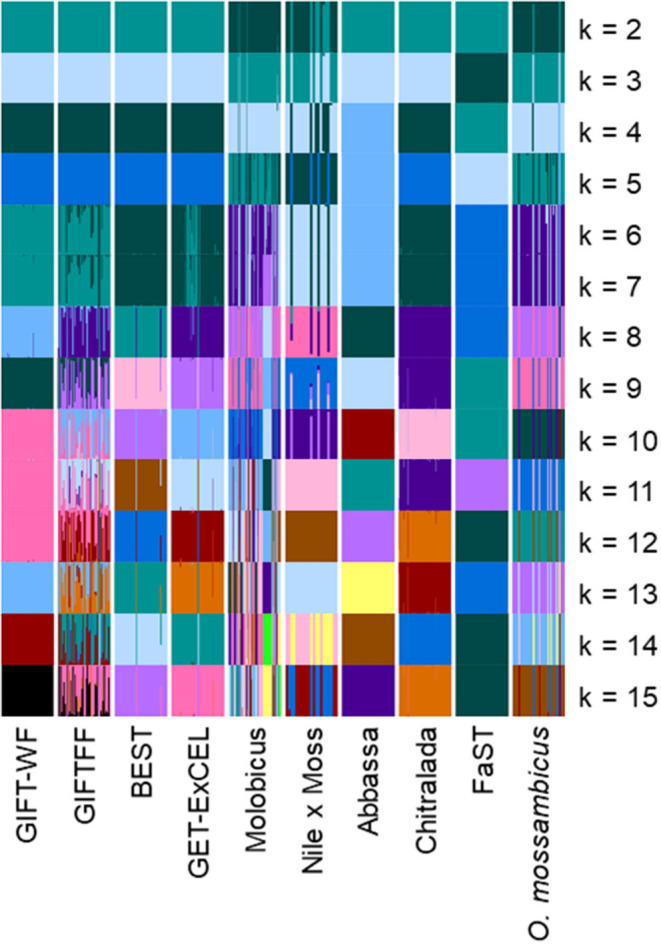
Unsupervised k-means clustering of individuals in core breeding populations performed using discriminant analysis of principal components (DAPC) for differing numbers of groups (k) using the reduced subset of informative SNPs. Each of the groups is represented by a different color. Vertical lines represent the cluster membership probability of individuals.